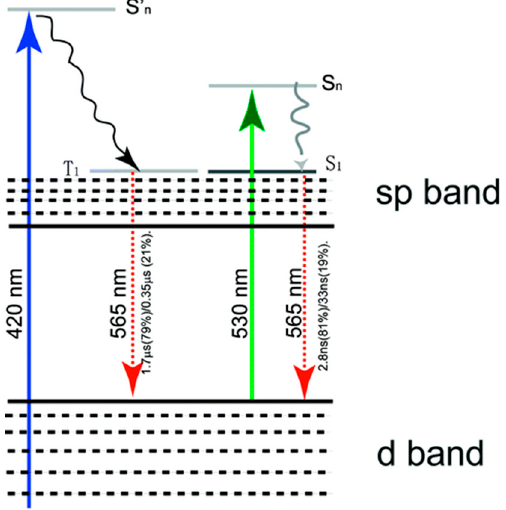
Figure 7. A possible optical transition scheme for orange-emitting GS-AuNPs where the luminescence originates from transitions between d and sp bands. When the NPs are excited at 420 nm, the electrons will be relaxed from triplet states in sp bands to some ground states in d bands, leading to microsecond emission. Once the excitation wavelength is shifted to 530 nm, the electrons will be decayed from singlet excited states in the sp band to singlet states in ground states and give out a nanosecond emission. The triplet and singlet excited states in the luminescent gold nanoparticles are degenerate in energy. Reprinted with permission from Ref. [44]. Copyright (2010) American Chemical Society.